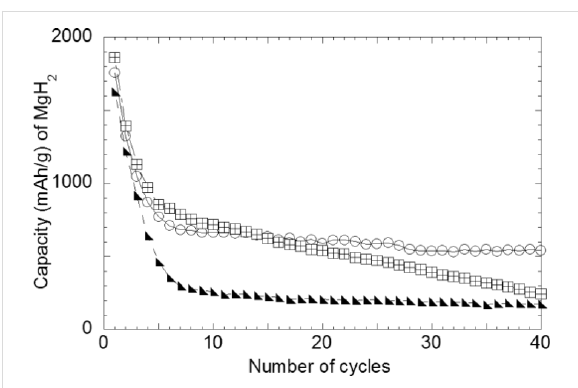
Figure 21: Electrochemical cycling performance for MgH 2 composite electrodes: MgH 2 –18% C t , z (black triangles), 33.3% MgH 2 –33.3% CMC–33.3% C t , z (open squares) and 33.3% MgH 2 –33.3% CMC- f–33.3% C t , z (open circles). Cycling between 3 and 0.005 V, rate of one equivalent of lithium in 10 h. Adapted from [46]. Copyright 2011